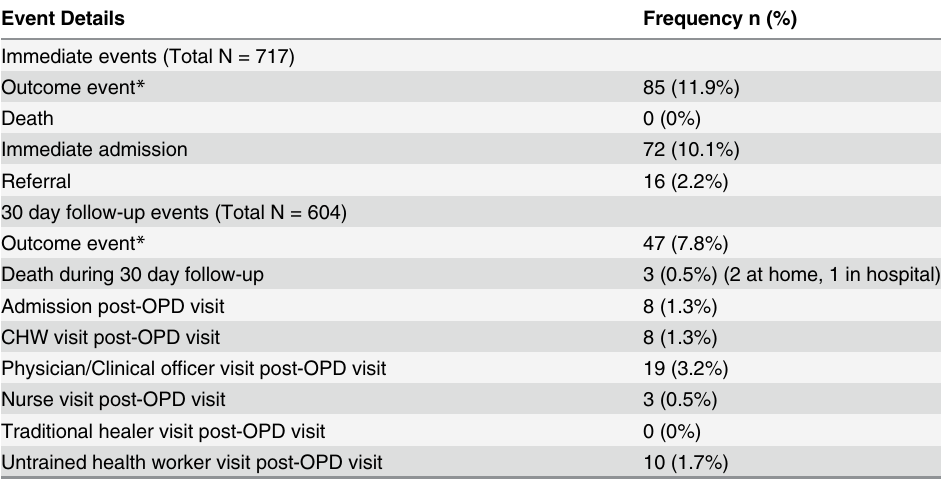
Table 3. Outcomes of subjects during SCV and during 30 day follow-up